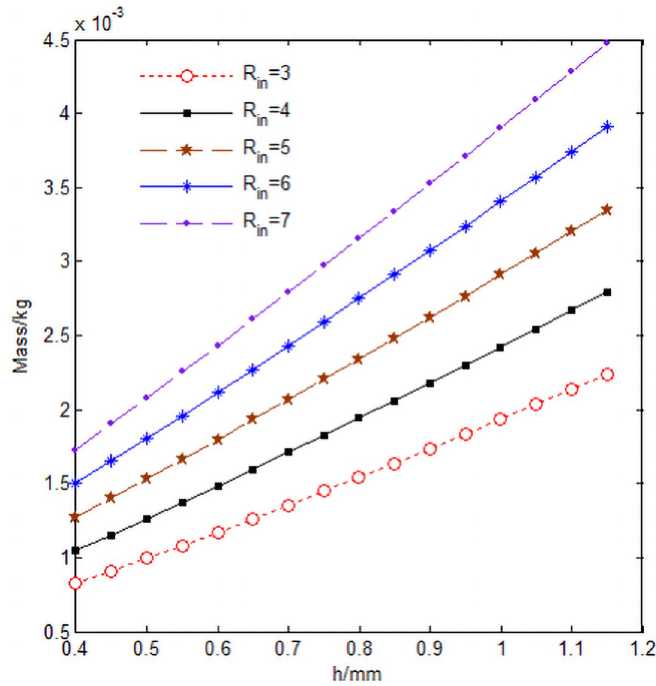
Fig 13. Relationship curve of cell mass m , knuckle length h and cell inner diameter R in